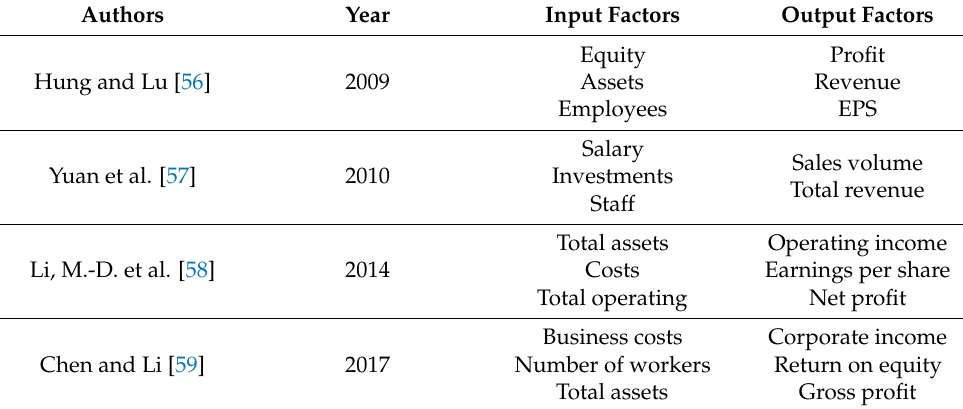
Table 5. Related research’s DEA inputs and outputs.